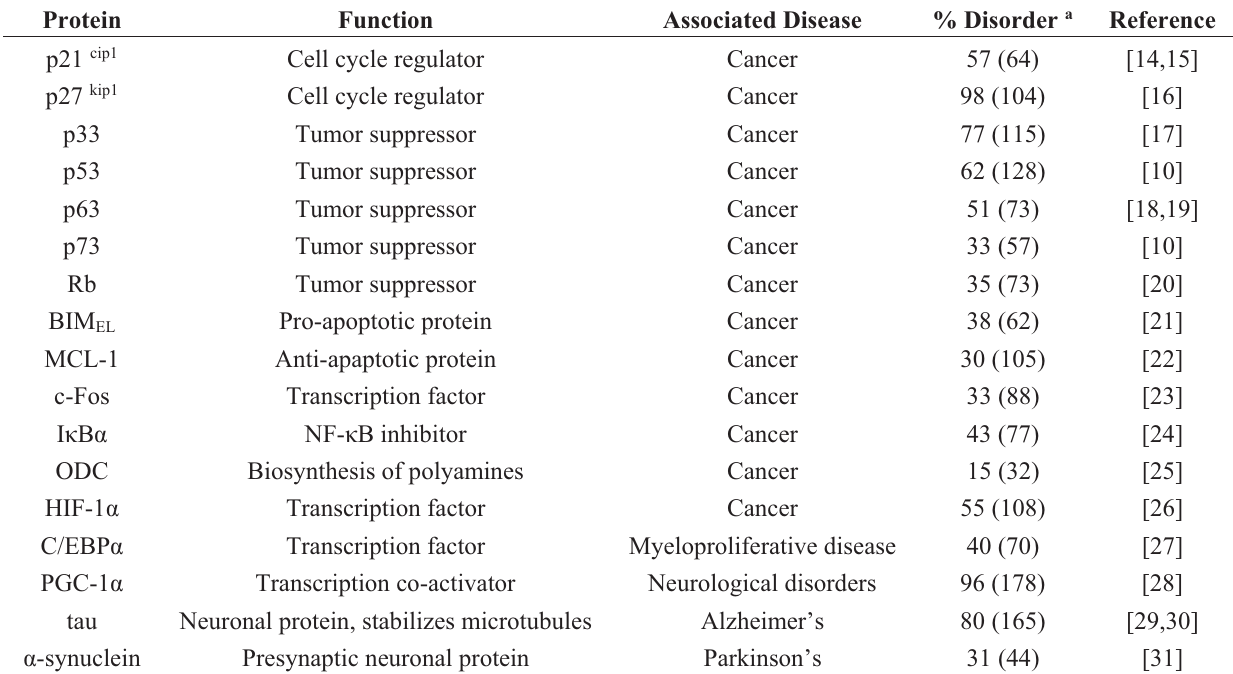
Table 1. A list of proteins with varying degrees of disorder that serve as 20S proteasome substrates.